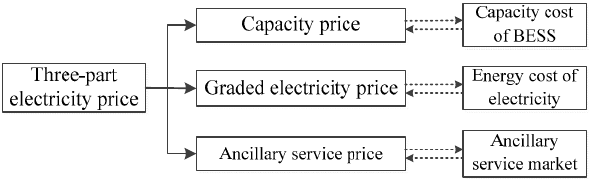
Figure 3. The basic structure of the three-part electricity price.